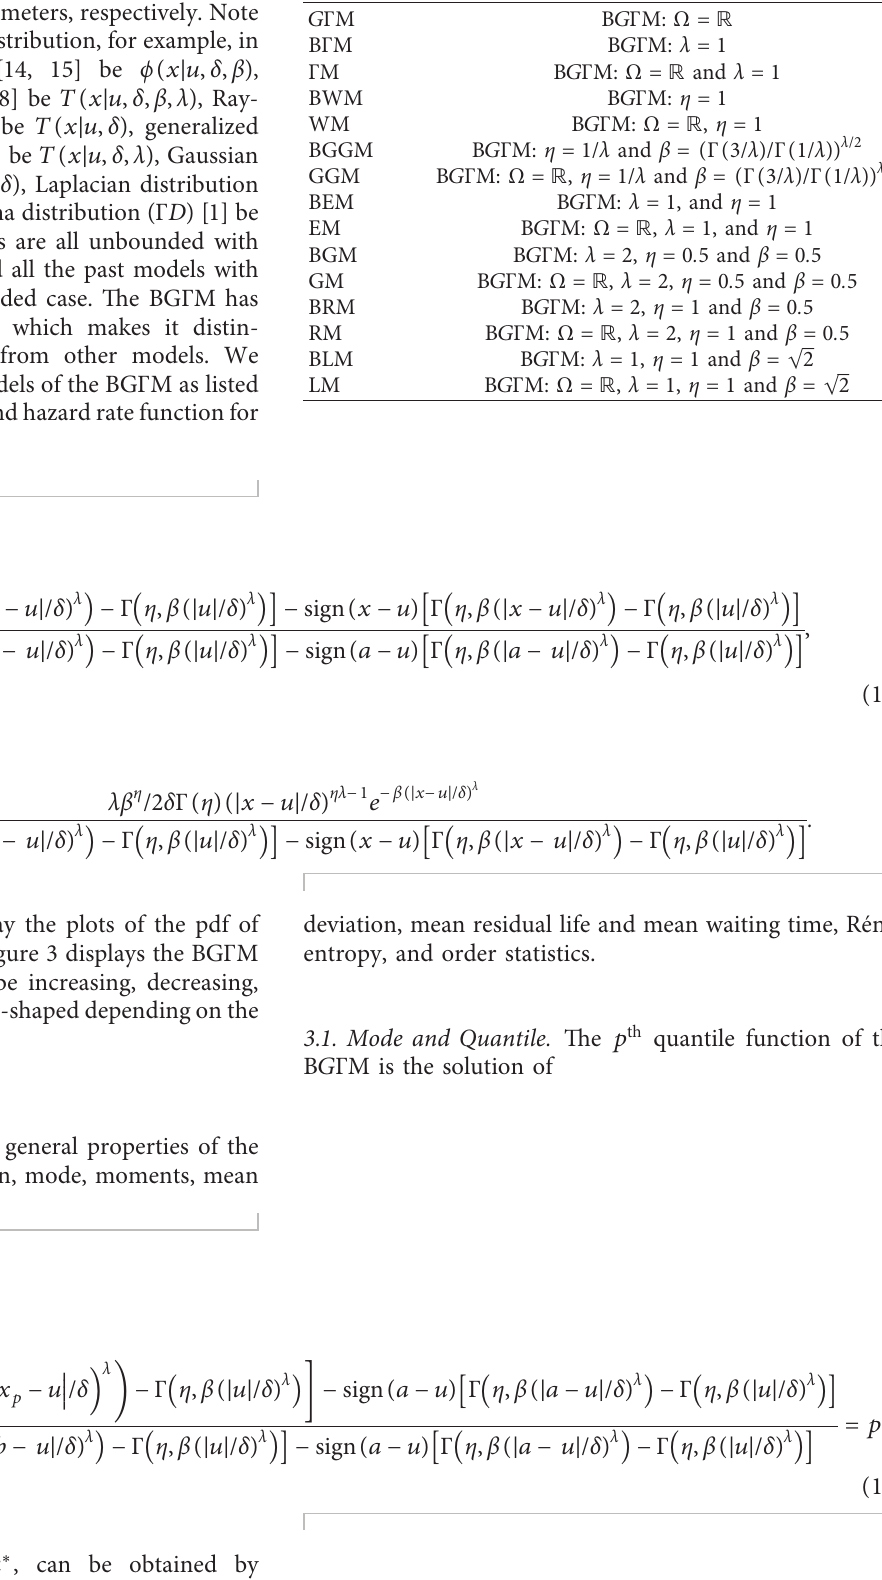
Table 1: The comparative models are special cases of the B G Γ